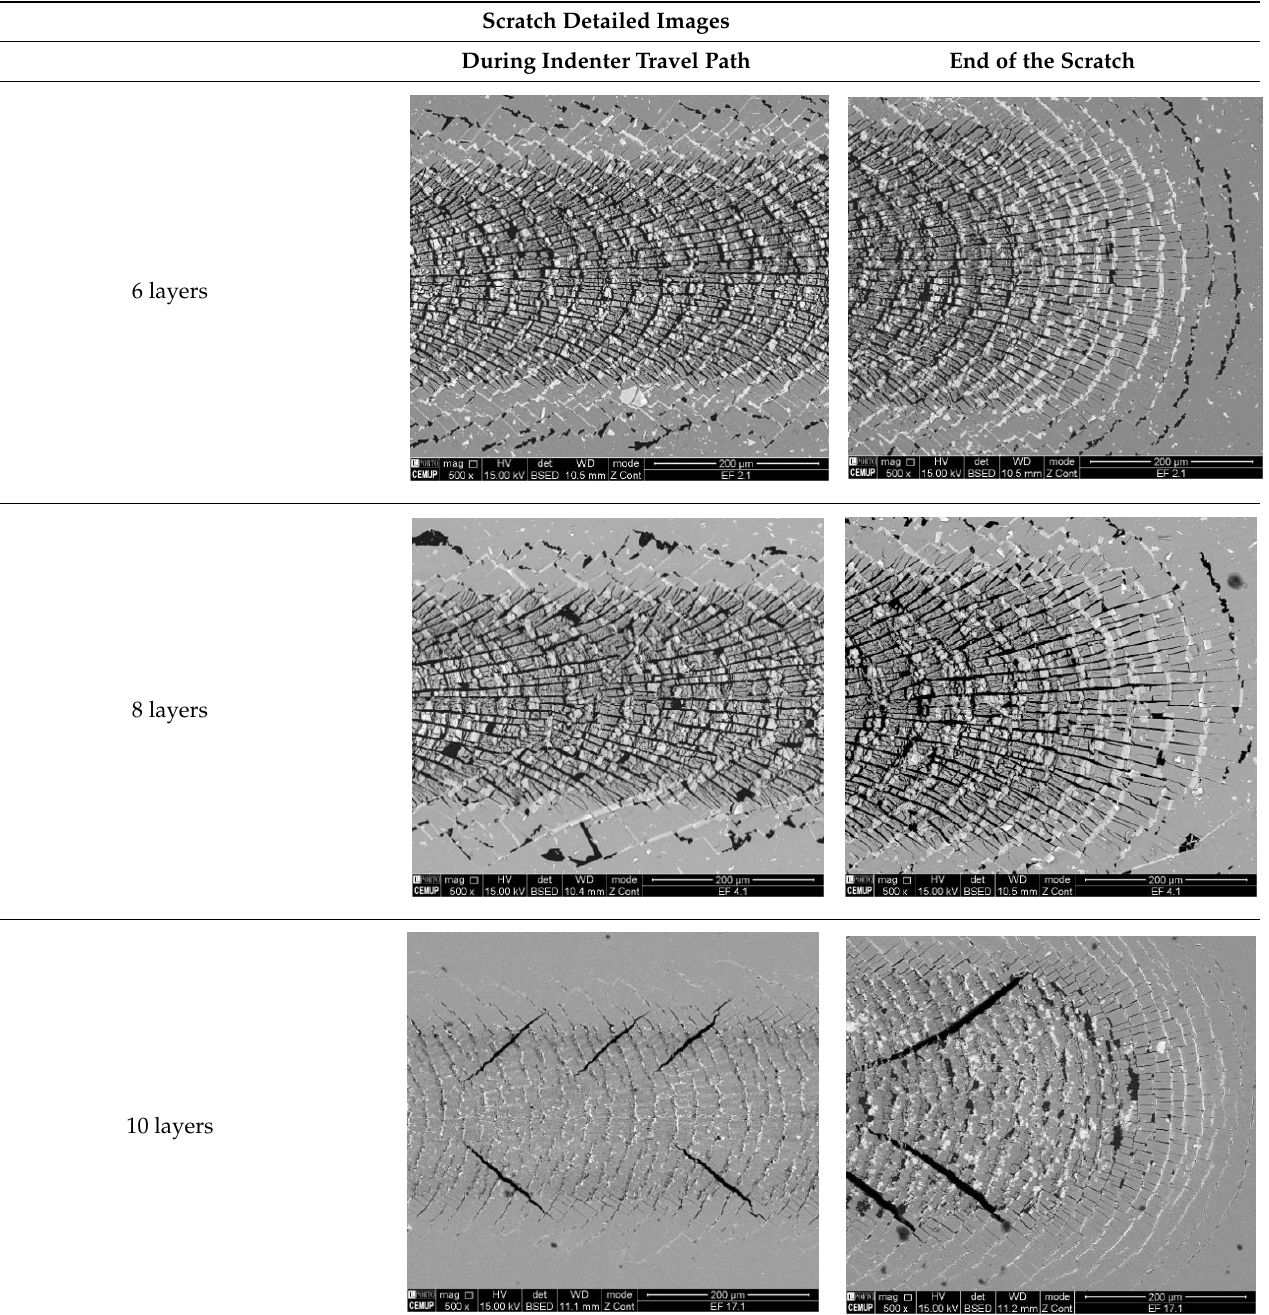
Table 5. Detailed images of the scratches produced during the scratch-tests (general magnification: 500 × ).